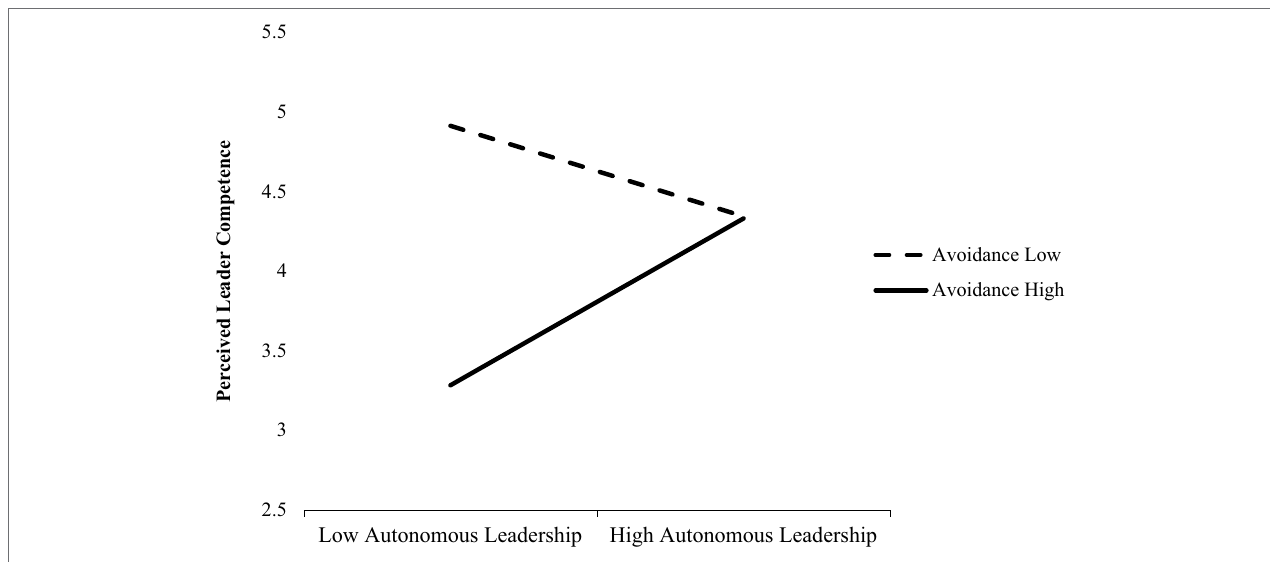
FIGURE 2 | Regression of the interaction of avoidance attachment and autonomous leadership on perceived leader competence conditions (Study